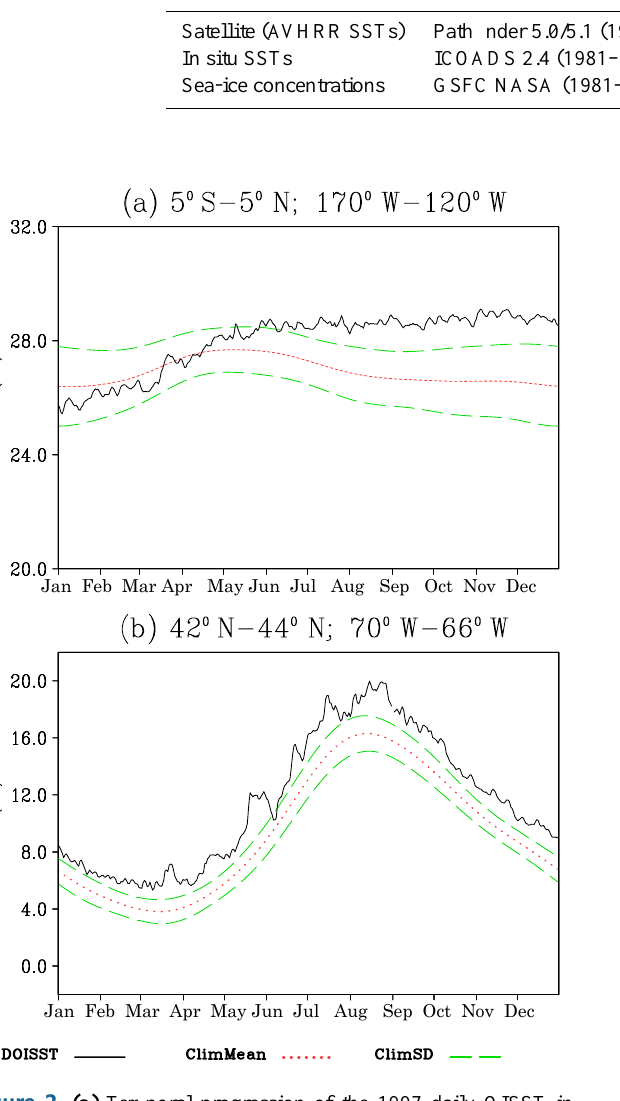
Figure 2. (a) Temporal progression of the 1997 daily OISST in the NINO3.4 region (solid line) and the 1982–2011 climatological mean (short dash) for the same area. The offset from the mean by plus and minus 1 standard deviation (long dash) shows character- istic variability. (b) Same but in 2012 in the Gulf of Maine (after Mills et al., 2013). Titles show coordinates used to compute the area weighted means.